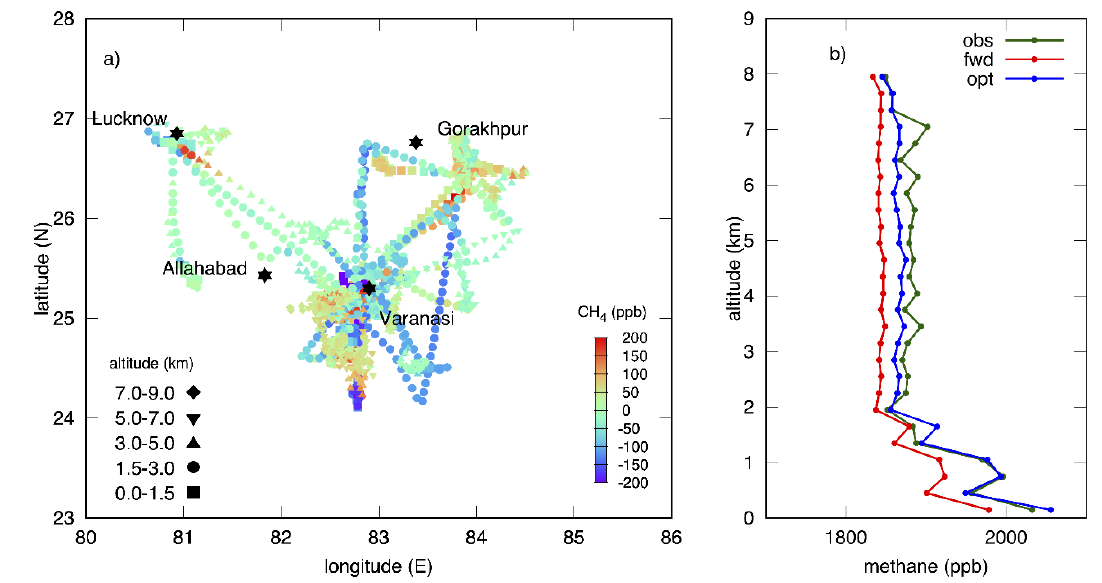
Figure 5. ( a ) Track of aircraft observation of methane over the Indian domain, where the colors show the difference between optimized forward and observations. To facilitate visual clarity, not all observations are shown. The black stars represent cities around the region. Names of the cities are labeled in black. Observations at different altitudes are shown with different symbols, as shown in the legend. ( b ) The vertical profile of 300 m averaged aircraft observations against prior forward and optimized forward simulations.